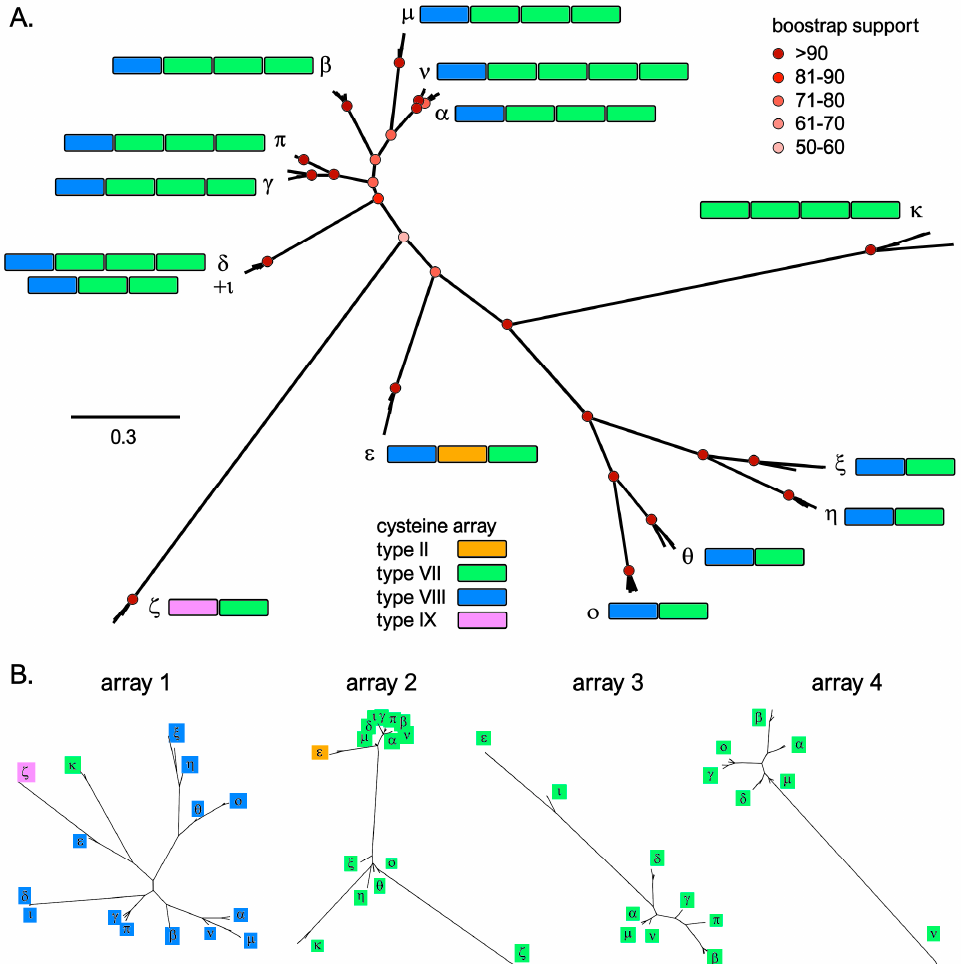
Figure 4. Panel ( A ): maximum likelihood unrooted phylogenetic tree of mussel mCRP-I sequences. Each of the 15 groups of sequences are indicated with a Greek letter, and the number and organization of cysteine arrays are indicated by the presence of color. For simplicity’s sake, only the bootstrap support values of the major nodes of the tree (i.e., those defining the 15 sequence groups, or more basal ones) are displayed. Panel ( B ): maximum likelihood unrooted phylogenetic trees based on the multiple sequence alignment of the four cysteine arrays found in mCRP-I peptides; array 5, exclusively present in group ν , was not included.